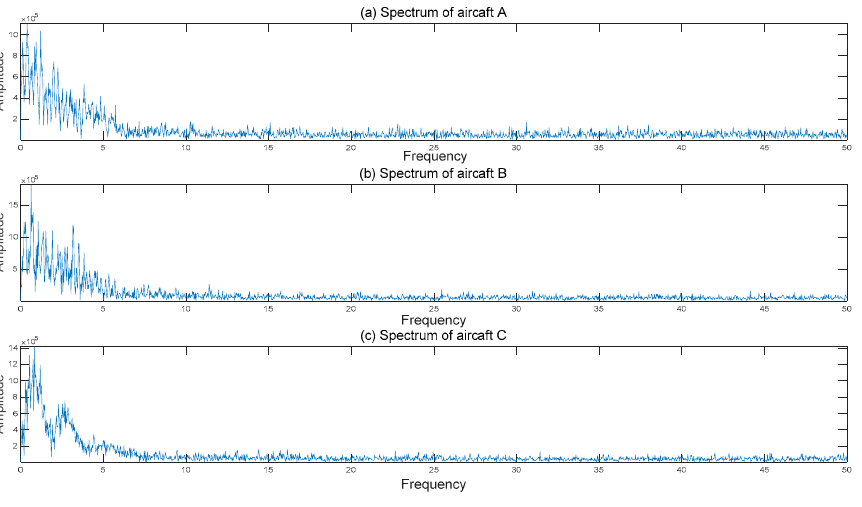
Figure 7. The spectrums of seismic vibration signals from the three aircraft. As shown in Figure 7, the seismic vibration signals of all three aircraft excited by the sound waves are mainly low-frequency signals under 5